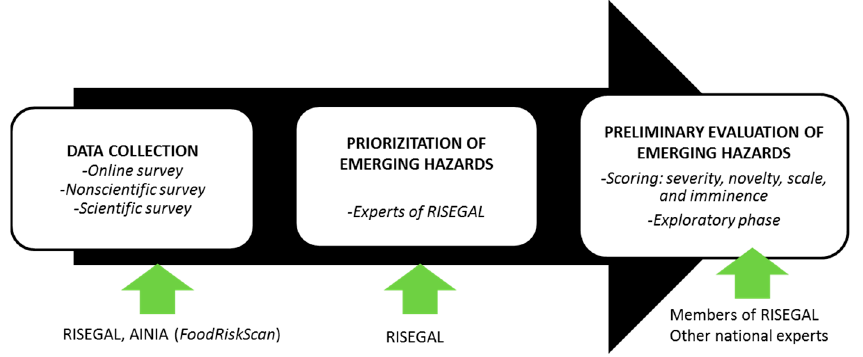
Figure 2. Scheme of the approach used by RISEGAL for the identification of emerging hazards.